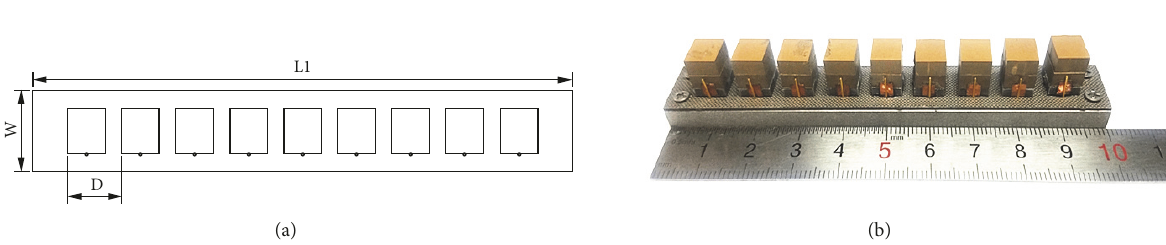
Figure 7: Configuration of the DRA array. (a) Array elements arrangement diagram. (b) Prototype of the proposed DRA